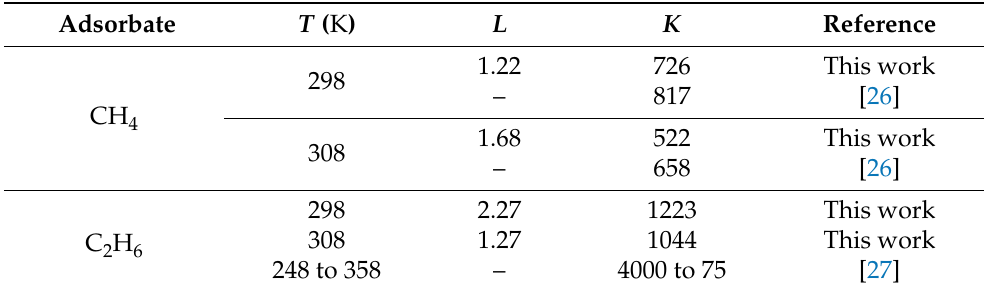
Table 1. Experimental temperature ( T ) , time constant ratio ( L ) and dimensionless Henry law constant ( K ) for equilibrium measurements of methane and ethane on zeolite